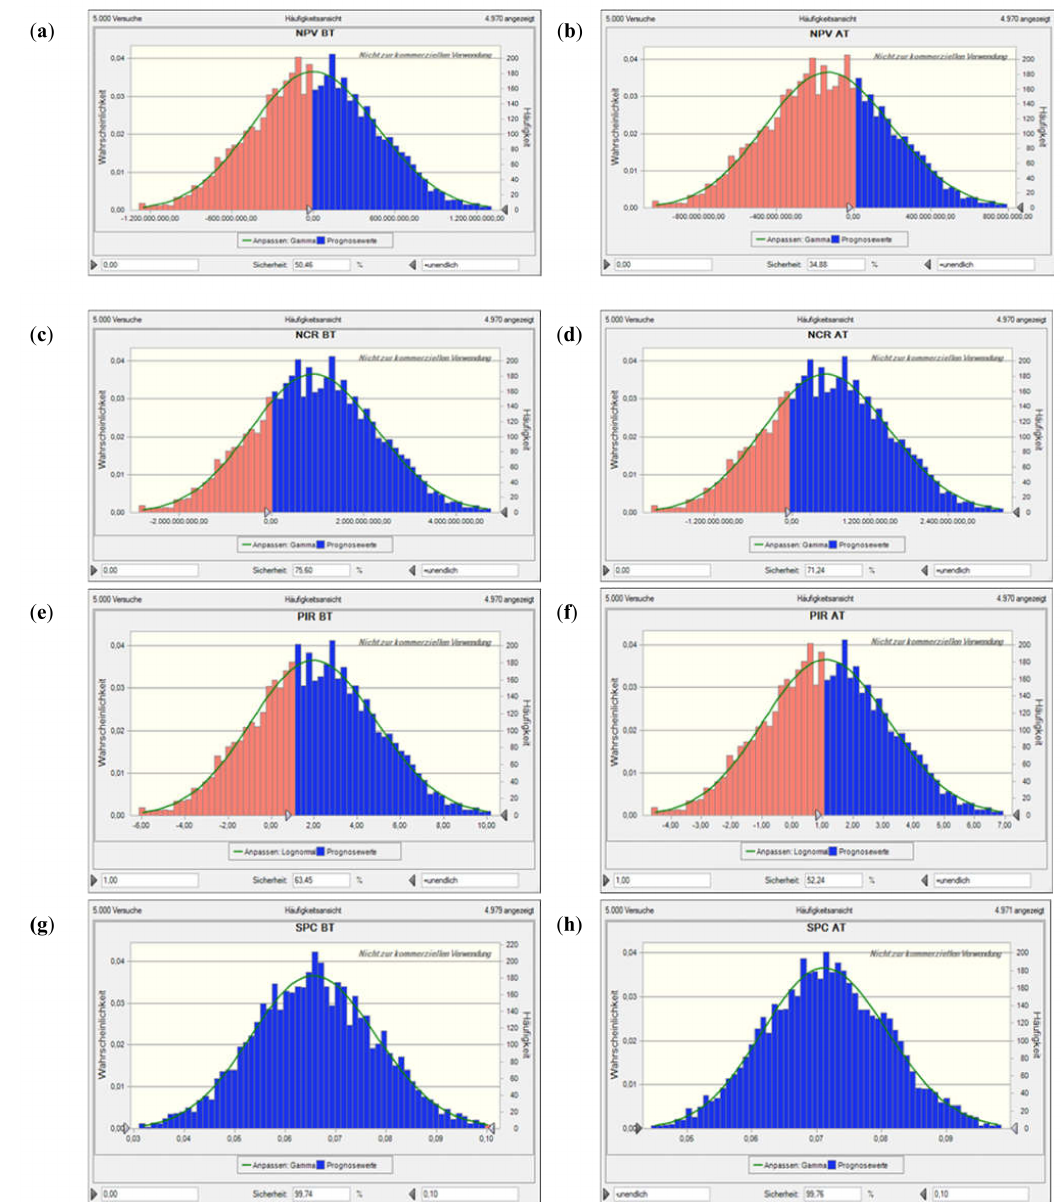
Figure A4. Value at risk for Scen. 2, excl. flooding time, based on a monte Carlo simulation with 5000 runs. Plots ( a ) and ( b ) show the net present value (NPV) before and after tax, plots ( c ) and ( d ) the NCR before and after tax, plots ( e ) and ( f ) the profit-to-investment ratio (PIR) before and after tax, and plots ( g ) and ( h ) the per unit (specific) production costs (SPC) before and after tax. The solid lines denote the fitted probability distribution, the red areas the confidence interval of not encountering a neg. NPV, neg. NCR, or PIR < 1 (i.e., depending on the performance indicator concerned; as the costs considered are all positive, there is only a blue histogram in those two